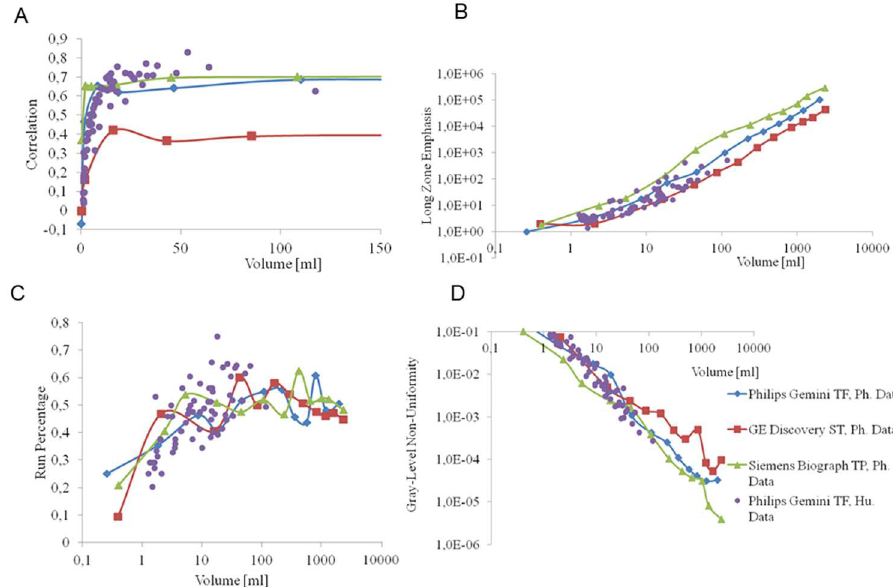
Fig 4. Representative volume dependence of four different HePs. Phantom data points (“Ph.Data”) measured on three different scanners are differentiated by continuous color lines. Individual data points calculated from human lung lesions are displayedas the individualpurple dots (“Hu.Data”). The volume dependence of the all investigated parameterscan be found in the Supplemental Material.